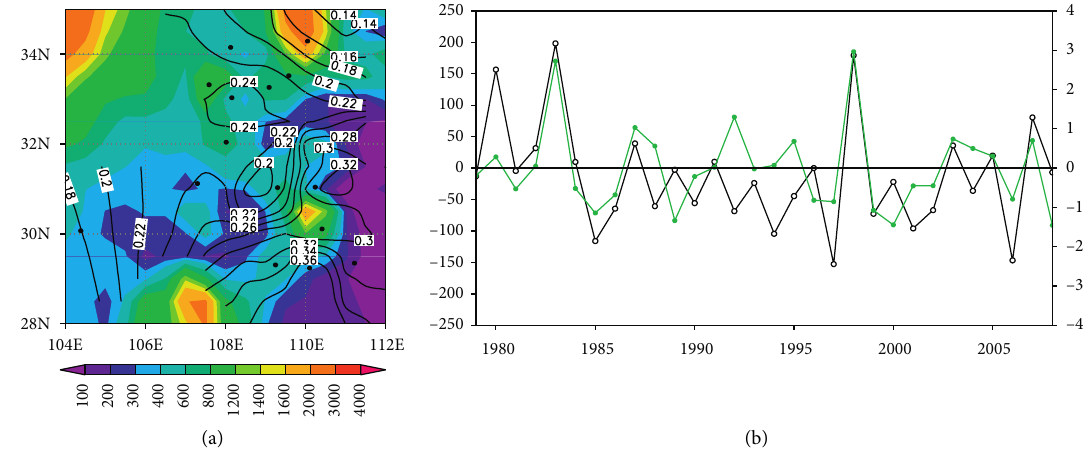
Figure 4: Distribution of first eigenvector (a) and principal component (b) of EOF analysis to the summer precipitation based on the 15 stations data in the western mountainous region. The variance contribution of the first eigenvector is 47%.